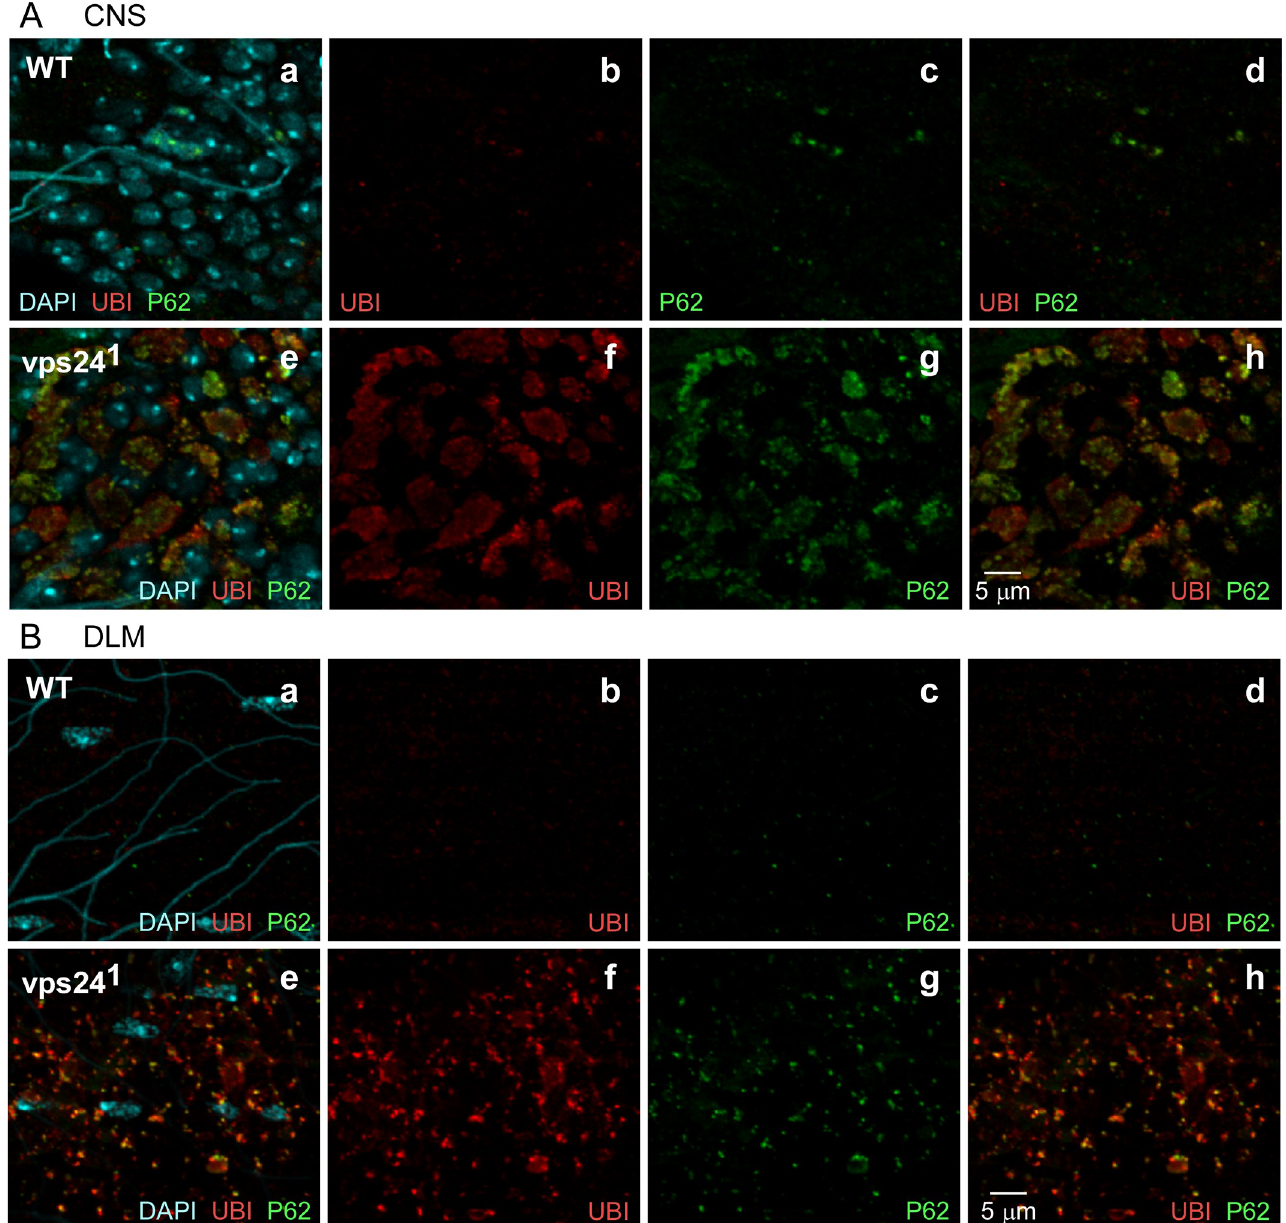
Fig 8. Disruption of autophagy contributes to accumulation of ubiquitin-positive compartments in the vps24 mutant. Confocal immunofluorescence images of CNS neurons (A) and DLM (B) from WT (a-d) or the vps24 mutant (e-h) . Localization of endogenous P62, the autophagy adaptor protein, was used to mark intermediates in autophagy. In both neurons and muscle, the vps24 mutant exhibits accumulation of P62. The distribution of P62 overlaps with but is more punctate and restricted than that of the ubiquitin-positive compartment. https://doi.org/10.1371/journal.pone.0251184.g008 tubular network was observed. These EM studies also revealed accumulation of autophagic intermediates in both CNS neurons and DLM flight muscle of the vps24 mutant, but not in wild type, consistent with immunocytochemical (Fig 8 and S8 Fig) and live imaging studies (Fig 9). As described previously [64, 68], phagophore or autophagosome intermediates exhibit a characteristic cleft between membrane sheets (Fig 10Ab and 10Bb for neurons and muscle,